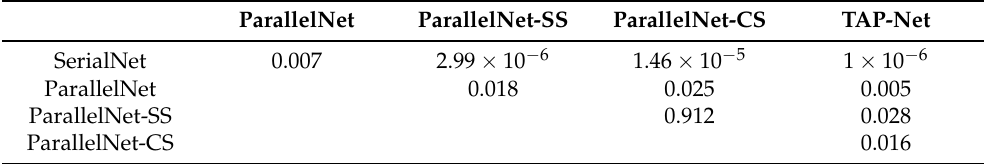
Table 10. Results of two-tailed Wilcoxon’s tests over per-class accuracy for proposed methods.